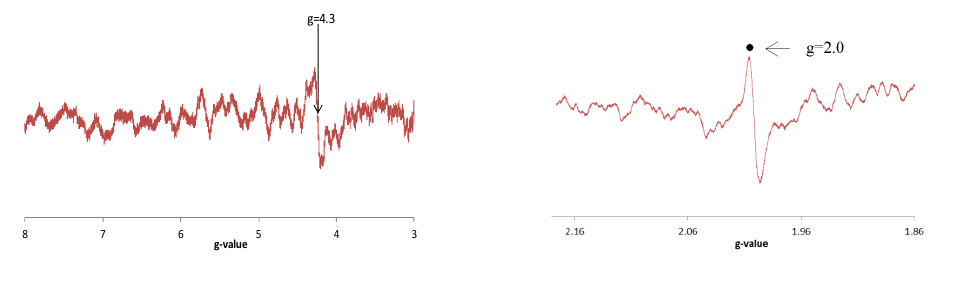
Figure 4. Electron spin resonance (ESR) spectra of Fe(III) from ( a ) HasApf, 0 h; ( b ) HasApf, 50 h; and ( c ) HasApf, 100 h or ultrafiltrated supernatant 2. In ( a ), numerous signals appear at g = 6.0, 2.8, 2.22, and 1.72, suggesting the presence of axially symmetric low ‐ spin ferric His/Tyr ‐ heme iron; In ( b ), three signals disappear at 2.8, 2.22, and 1.72, suggesting the coordination of oxygen; In ( c ), two signals appear at g = 4.3 and 2.0, suggesting the ferric form (oxoferryl (Fe IV =O)). “Signal Intensity” y axis appears quite noisy because of the lower concentrations of HasApf (40 μ M) including rac ‐ 2 (0.8 mM) for ESR resolution.